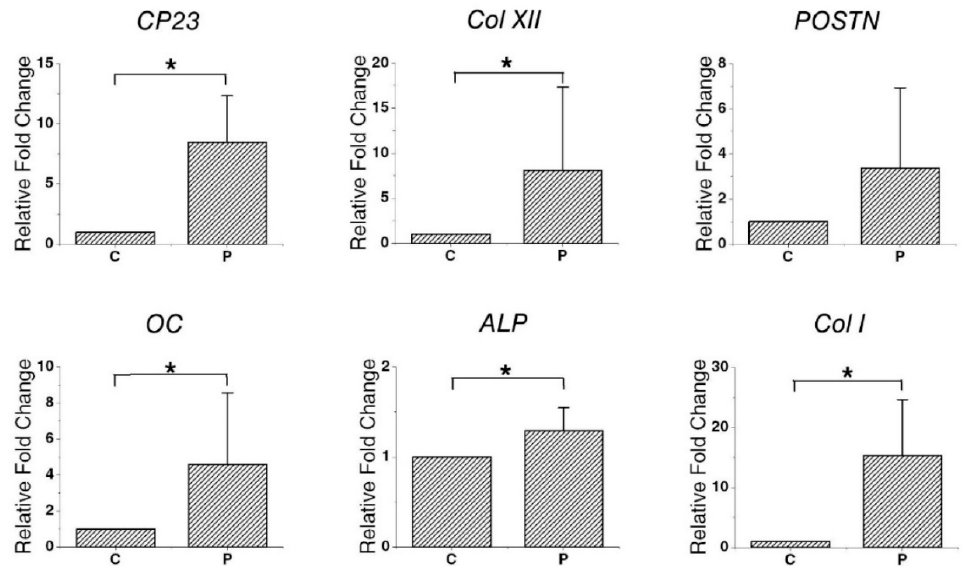
Figure 3. Evaluation of gene expression level by relative fold changes for genes encoding CP23 , Col XII , POSTN , OC , ALP , and Col I in dHPDL transplants. The expression levels of CP23 , Col XII , OC , ALP , and Col I differed significantly between the two groups (* p < 0.05). The expression of POSTN did not differ significantly between the two groups ( p > 0.05). Abbreviations: C, control group; P, PDLSC group, CP23 , cementum-derived protein 23; Col XII , collagen type XII; POSTN , periostin; OC , osteocalcin; ALP , alkaline phosphatase; Col I , collagen type I; dHPDL, decellularized human periodontal ligament.